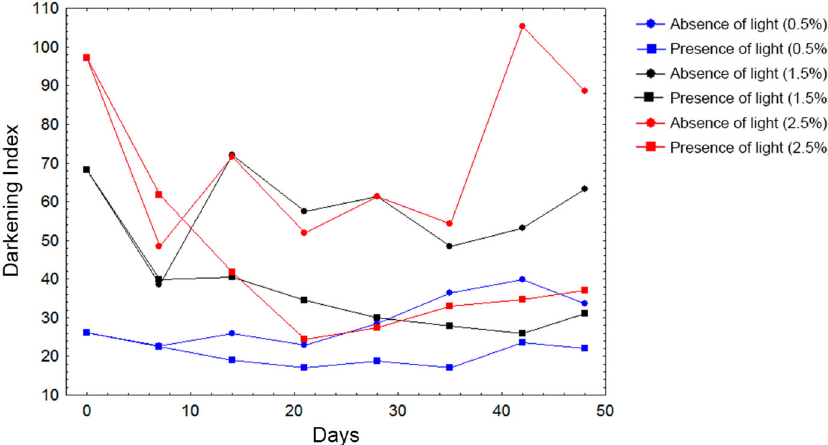
Figure 2. Darkening index related to 0.5%, 1.5%, and 2.5% ( m / v ) of fruit in ethanolic extracts throughout the following days in chamber in the presence or absence of light. The colors (blue, black, and red) represent the concentrations, while the forms (circles or squares) indicate the luminosity.